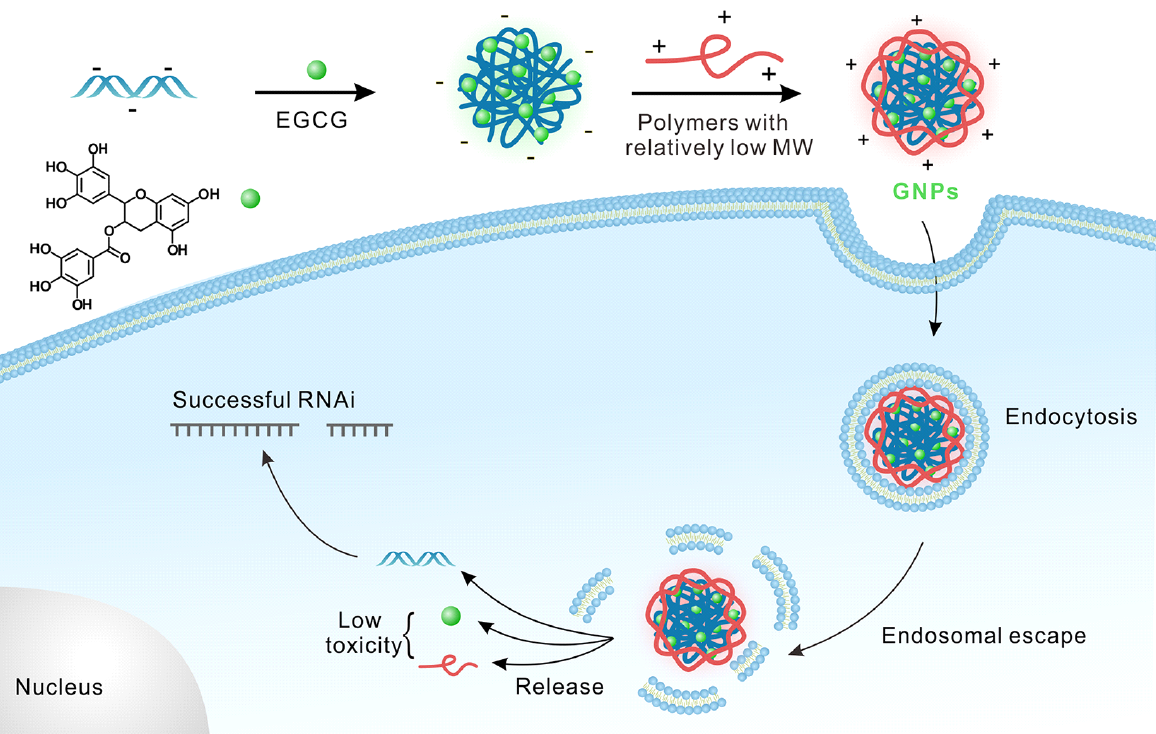
Figure 3. GNPs prepared by the supramolecular approach exhibited a gene silencing mechanism with high efficiency and low toxicity. Adapted with permission from Ref. [63]. Copyright © 2023 American Chemical Society.